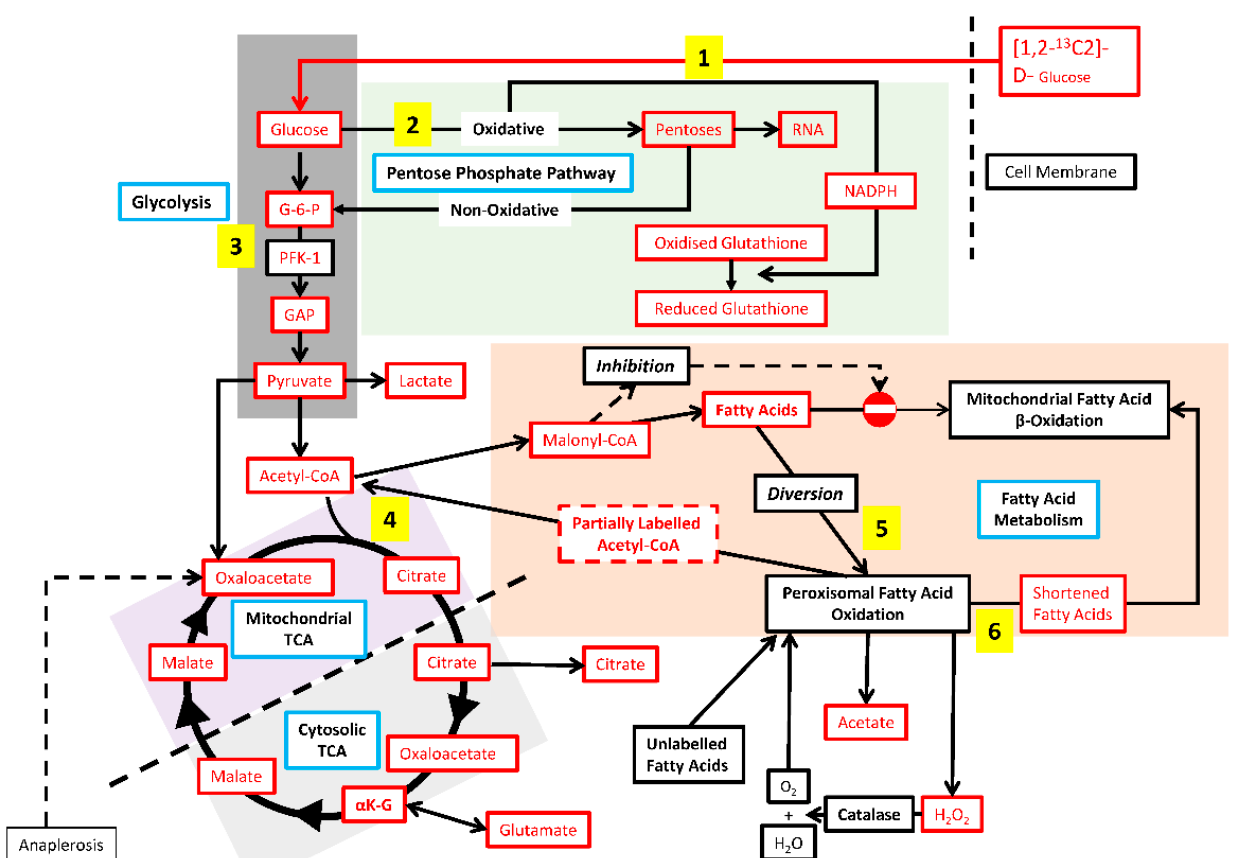
Figure 1. Diagram of metabolic pathways and relevant control mechanisms. 1—Glucose consump- tion, 2—Pentose phosphate pathway, 3—Rate-limiting step in glycolysis, 4—AcetylCoA to malo- nylCoA flux (de novo fatty acid synthesis), 5—Fatty acid diversion into peroxisomal fatty acid oxi-